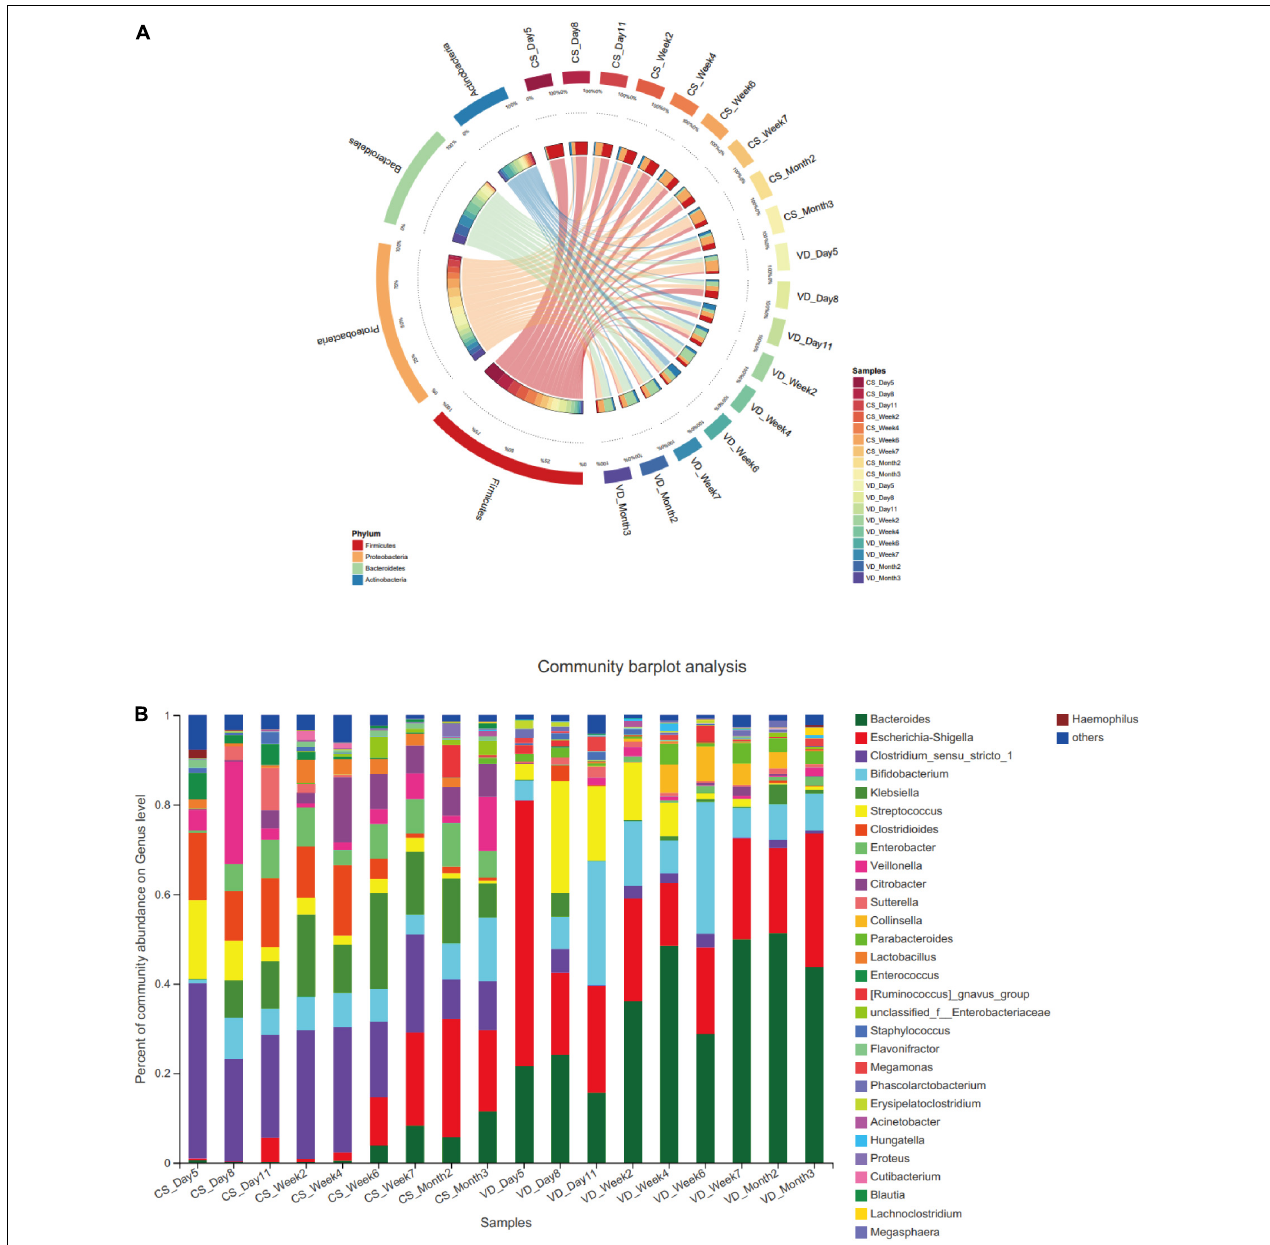
FIGURE 3 | Dynamic development of microbiota in the vaginal delivery and cesarean section groups. (A) Dynamic development of microbiota in phylum level; (B) dynamic development of microbiota in genus level; CS, cesarean section; VD, vaginal